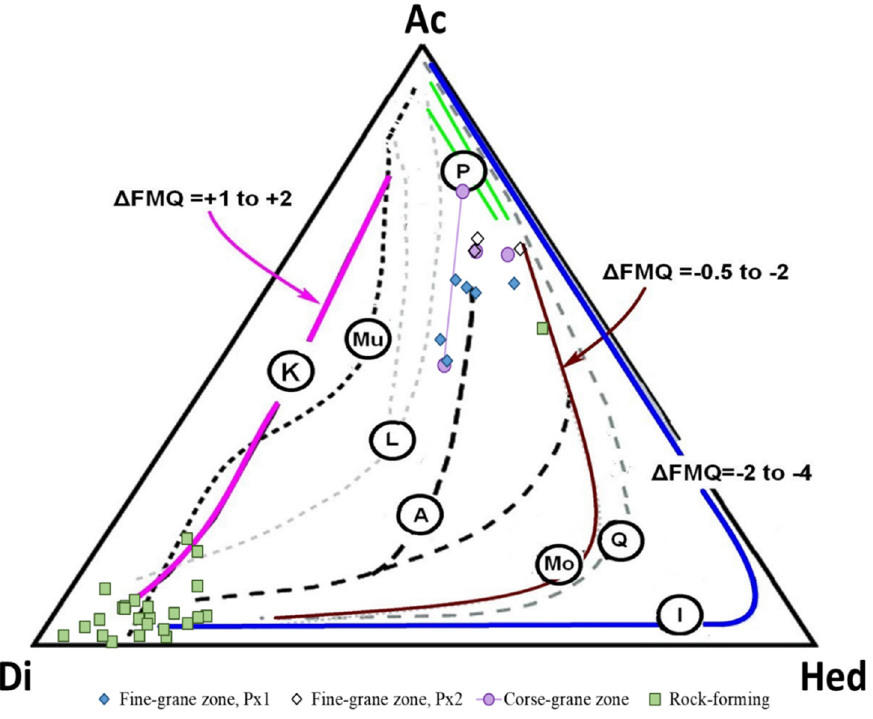
Figure 4. Composition of clinopyroxene from Odikhincha intrusion: our data for clinopyroxene from pegmatite and for rock-forming clinopyroxene (data from Ref [23]) in terms of Di-Hed-Ac (Mg–(Fe 2+ + Mn)–Na) in comparison with evolution trends of various alkaline complexes: (K) Katzenbuckel, SW Germany (Mu) Murun, Siberia, (L) Lovozero, Kola Peninsula, (A) Alnö, Sweden (Mo) Motzfeldt, South Greenland, (Q) North Q ộ roq, South Greenland, North Q ô roq, South Greenland) (I) Ilímaussaq. P- Pilansberg [24–27] Quantitative data on oxygen fugacity (given as Δ FMQ units, where FMQ is the fayalite-magnetite-quartz buffer) for Katzenbuckel, Ilímaussaq and Motzfeldt are given from Refs [24,27,28].